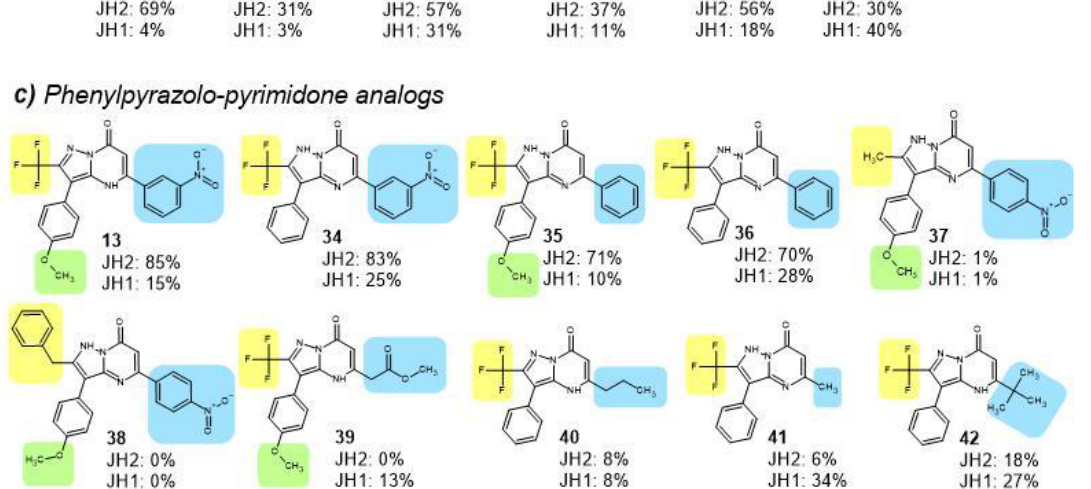
Figure 3. Chemical structures of selected analogs and binding to JAK2 JH2 and JH1 domains. ( a ) Diaminotriazole analogs, ( b ) diaminotriazine analogs, and ( c ) phenylpyrazolo-pyrimidone analogs. Subgroup R1 marked with yellow, R2 with green and R3 with blue background. Binding data are inhibition-% of tracer binding to recombinant JAK2 JH2 and JH1 domains at 100 µM analog concentration.